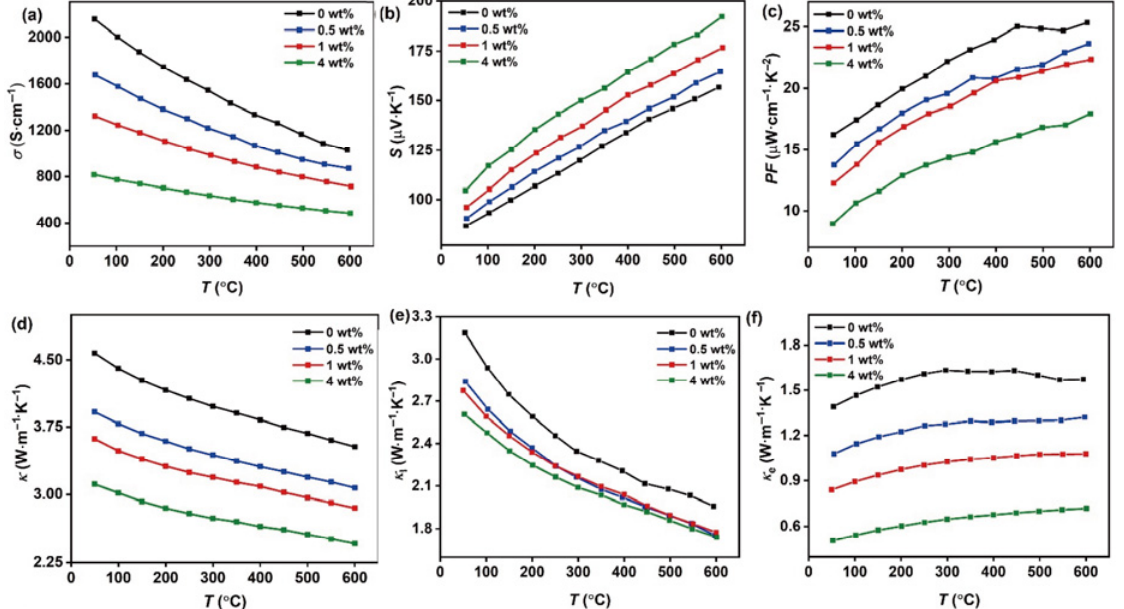
Fig. 5 Temperature-dependent TE properties for SiO 2 -composited (0–4 wt%) p-type Si 80 Ge 20 : (a)  , (b) S , (c) PF s, (d)  , (e)  , and (f)  l e